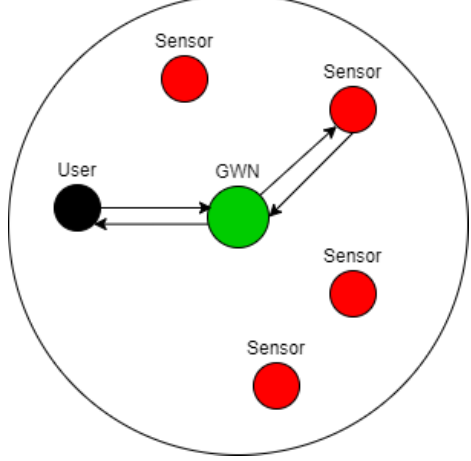
Figure 3. Single-gateway communication